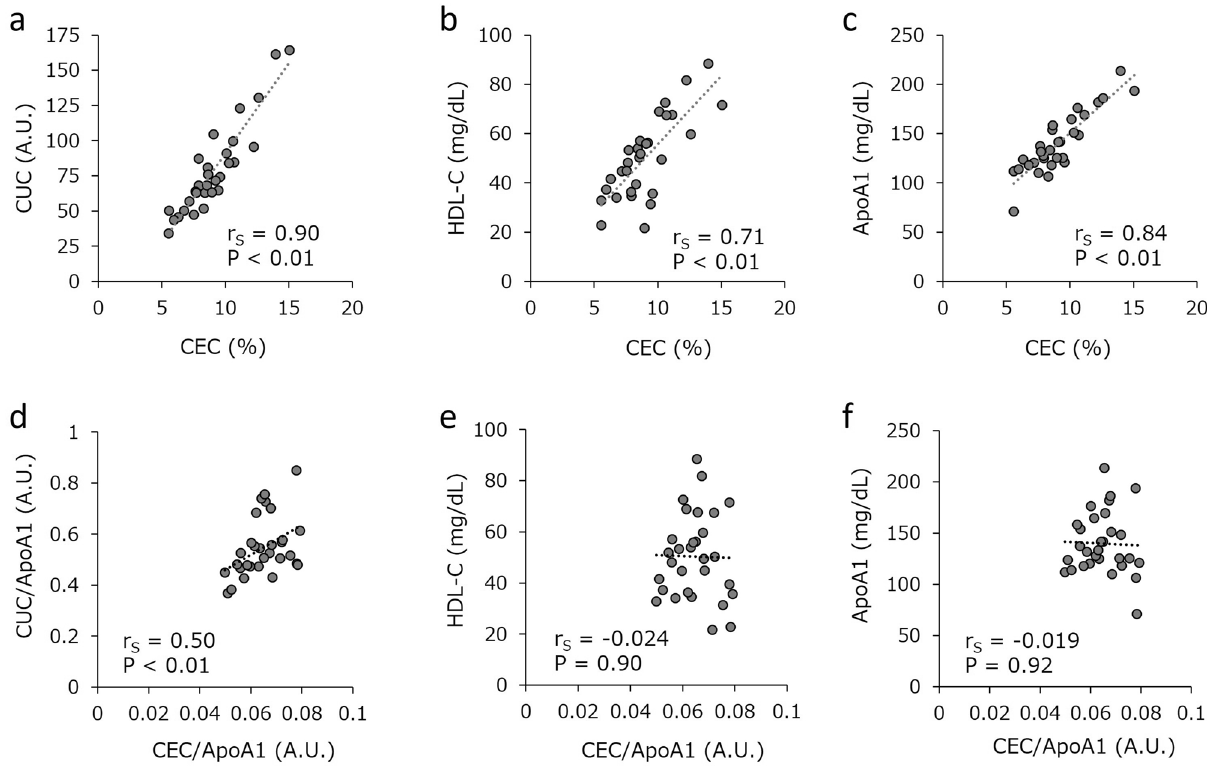
Figure 4. Relationship between CUC and CEC. Spearman’s rank correlation coefficient (r S ) between CEC and CUC ( a ), serum HDL-C ( b ), or serum ApoA1 ( c ) were analyzed. The r S coefficients between CEC and CUC normalized by serum ApoA1 ( d ), serum HDL-C ( e ), or serum ApoA1 ( f ) were also assessed. Serum and ApoB- depleted serum from 30 individuals were evaluated. The values represent single determinations (serum HDL-C and ApoA1) or the average of duplicate determinations per individual (CEC, CUC, CEC/ApoA1, and CUC/ ApoA1). A.U. arbitrary